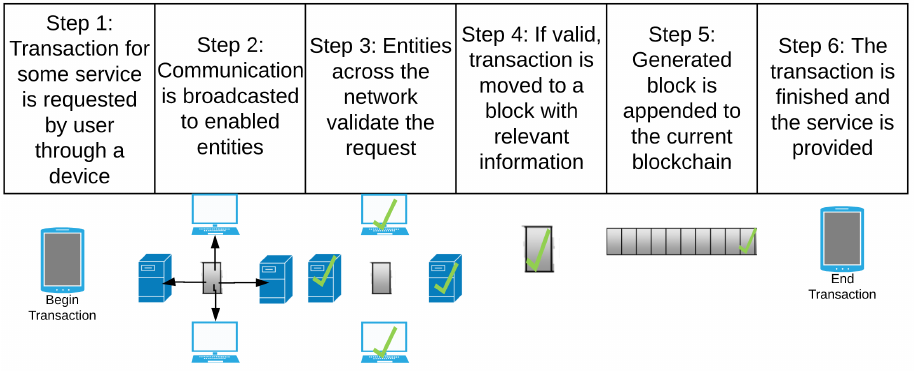
Figure 12. A diagram of the transaction-establishment and completion process, inspired by